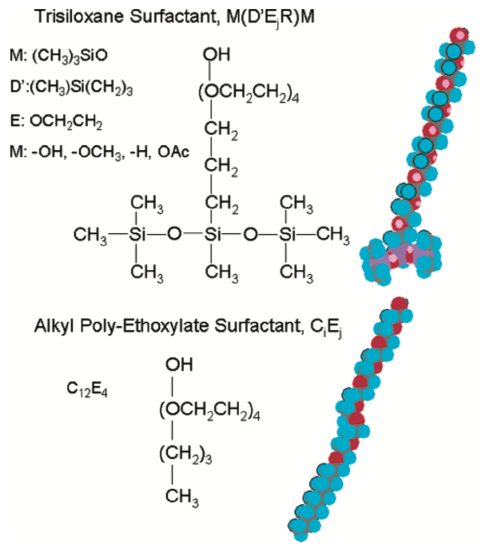
Figure 2. All-atom models. Atomic structures of a trisiloxane surfactant (top) and a n -dodecylpolyethoxylate surfactant (bottom). Oxygen atoms are in red, hydrogen atoms in blue, and silicon and carbon atoms in purple. Reprinted with permission from Ref. [68]. Copyright 2005 American Chemical